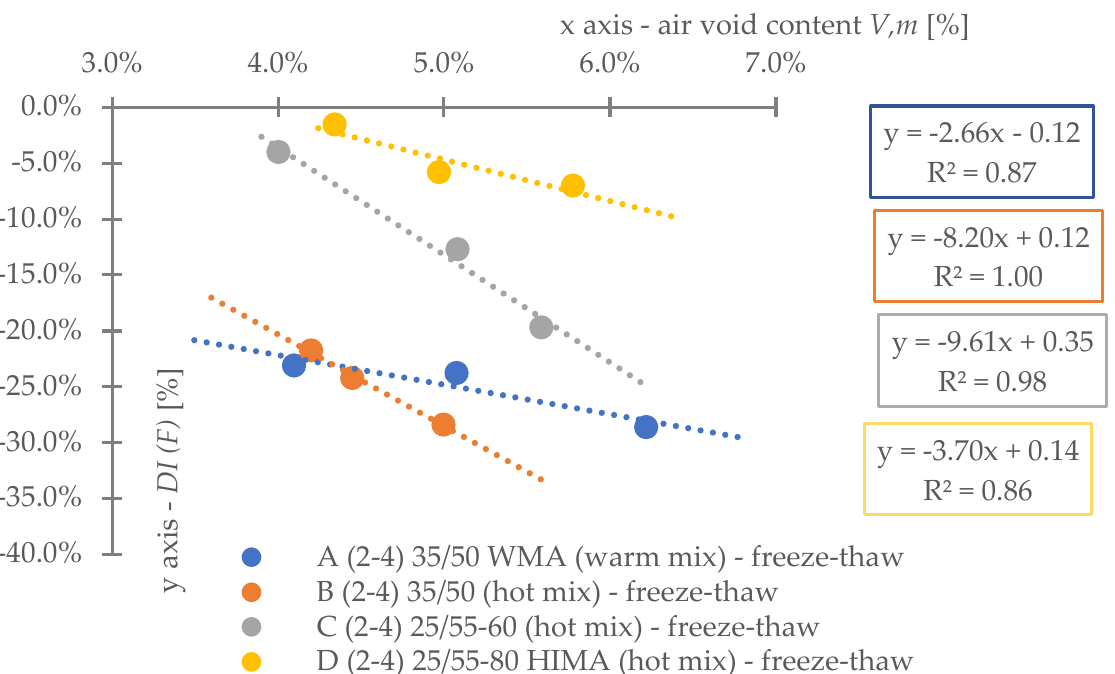
water-frost impact). Moreover, degradation caused by salt against water and frost ( 𝐷𝐼 (𝐹) ratio, Figure 13) in extreme cases: A (WMA) — is about 25% weaker (A4), B — is about 33% weaker (B4), C — is about 42% weaker (C4), and D — is about 3% weaker (D4) (comparable). The analyzed common road asphalts used in the mixtures char- acterized greater sensitivity to the negative impact of water and frost than road salt, similarly modified bitumens, while highly modified bitumens — similarly.